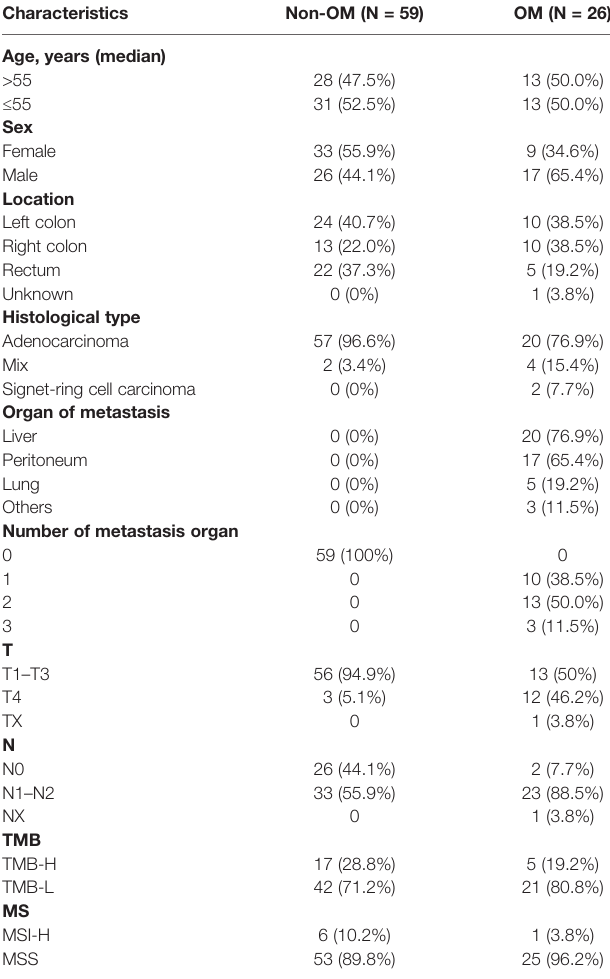
TABLE 1 | Clinical characteristics of our